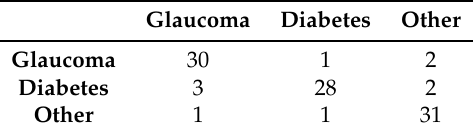
Table 4. MIRA confusion